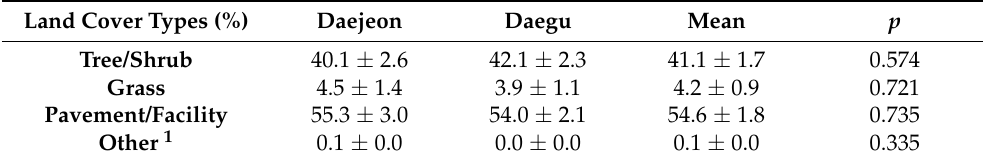
Table 3. Percentage of land cover types of urban parks sampled in the study cities. Land Cover Types (%) Daejeon Daegu Tree/Shrub